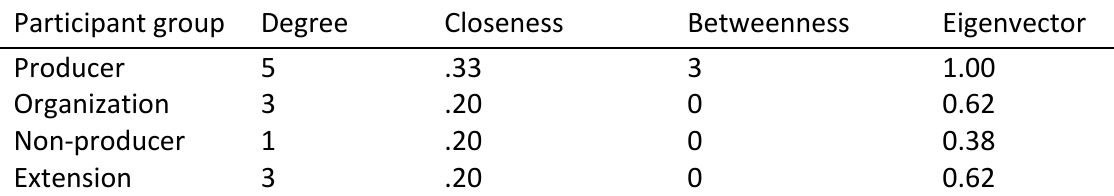
Centrality measurements for aggregated participant groups Participant group Degree